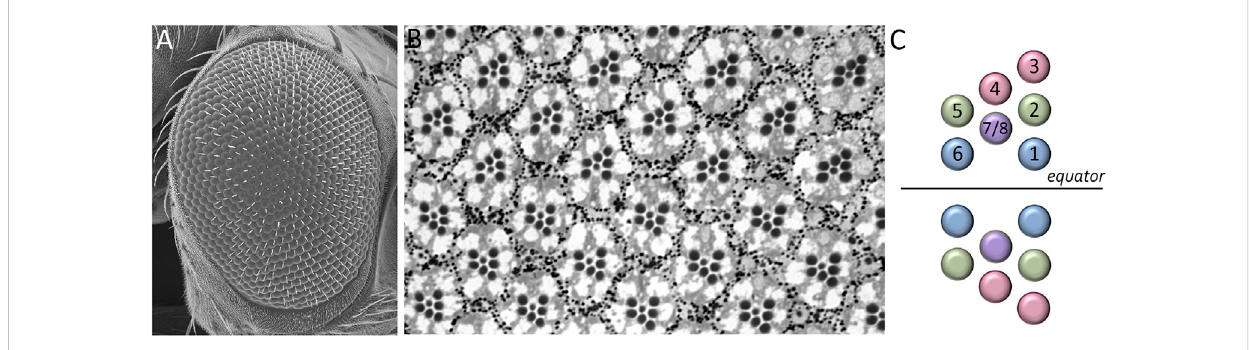
FIGURE 5 Structure of the adult Drosophila compound eye. (A) A scanning electron micrograph of the adult compound eye reveals that it consists of approximately 750 unit eyes or ommatidia that are organized into 32 – 34 columns. (B) A light microscope section of the adult retina shows that the eight photoreceptors that are contained within each unit eye are organized into an asymmetrical trapezoid pattern. The only difference between one unit eye andanotheristhechiralityofthetrapezoidwithinommatidia. (C) Aschematicshowingthedistinctchiralpatternsofommatidiawithinthedorsaland ventral compartments. These two compartments meet at the center of the eye which is called the equator.